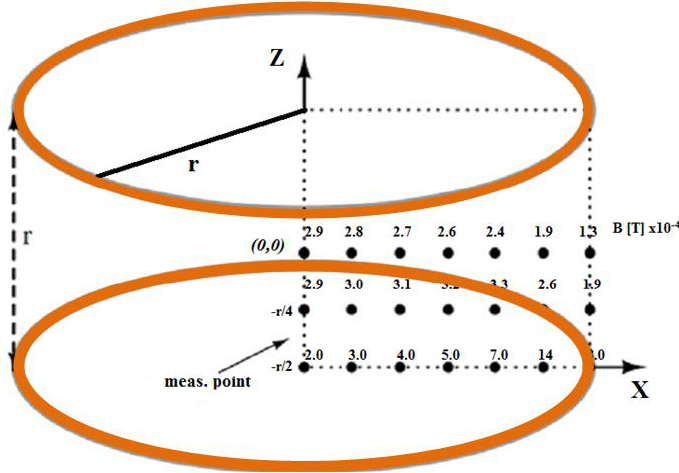
Figure 5. Magnetic field uniformity of Helmholtz coil (modified from